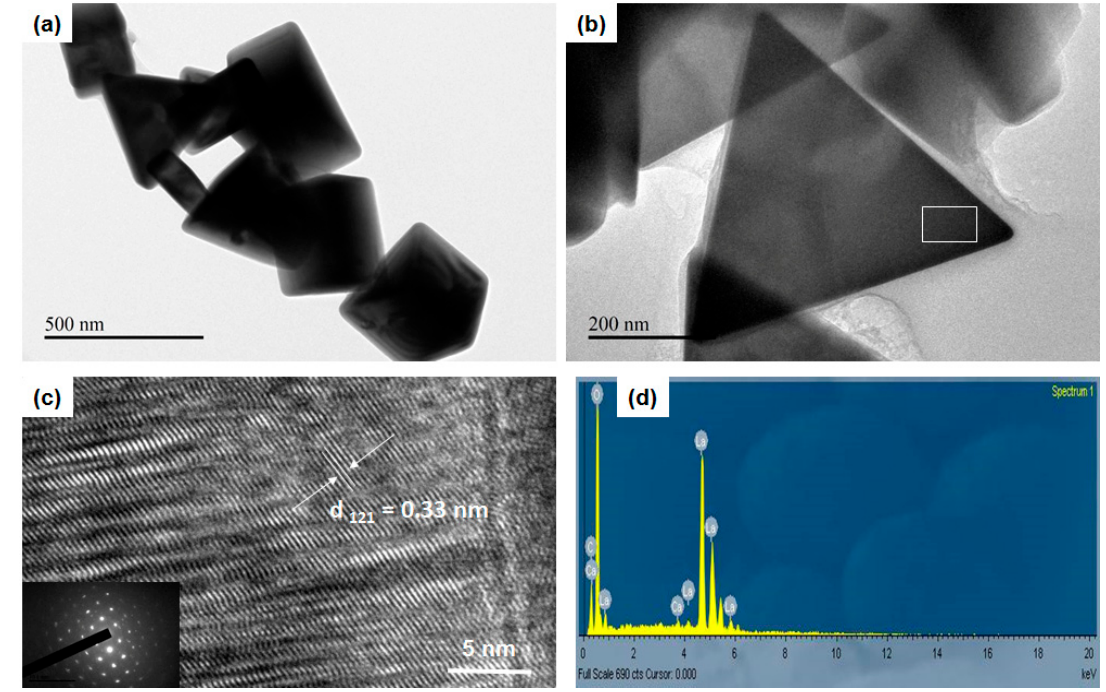
Figure 3. ( a ) TEM image of the LC-3 sample, its ( b ) high-magnification TEM image, and ( c ) the corresponding high-resolution transmission electron microscopy (HRTEM) image and selected area electron diffraction (SAED) pattern (inset in Figure 3b) obtained from the head region of a triangle. ( d ) EDS spectrum of an LC-3 nanoprism.